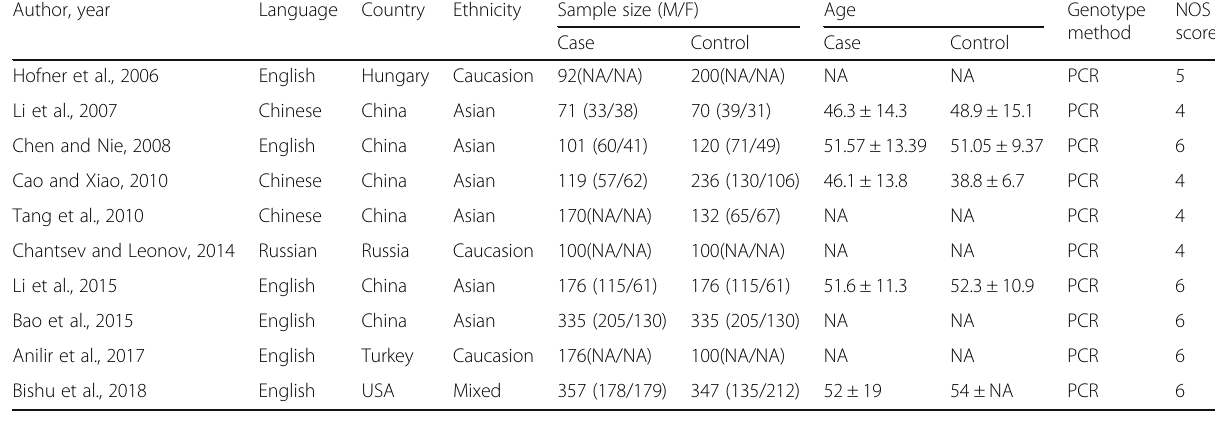
Table 1 Characteristics of included studies